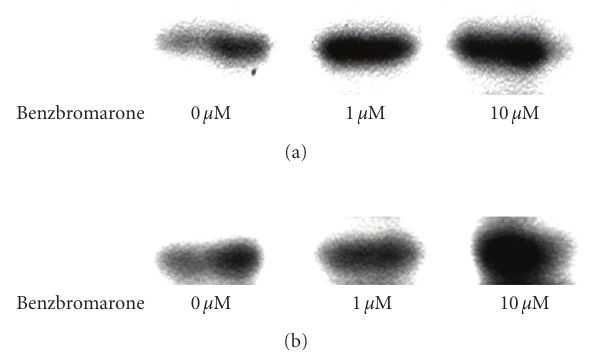
Figure 4: Expression levels of (a) LPL protein and (b) ACS pro- tein as determined by Western blot analysis in 293T cells with or without benzbromarone treatment for 24 hours. The optimal den- sity for each band measured using NIH Image. 1.6 is as follows: (a) LPL protein: 64.14 (0 μ M), 98.16 (1 μ M), 113.37 (10 μ M). (b) ACS protein: 51.05 (0 μ M), 63.29 (1 μ M), 94.66 (10 μ